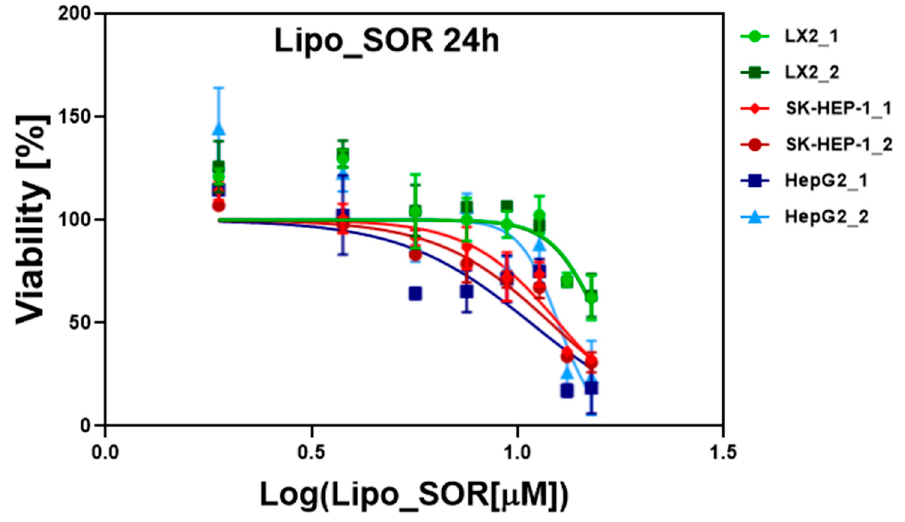
Figure 4. Evaluation of IC50 doses of Lipo_SOR treatment at 24 h. The experiments were performed in duplicates for each cell line. The SOR concentration was calculated based on EE values.